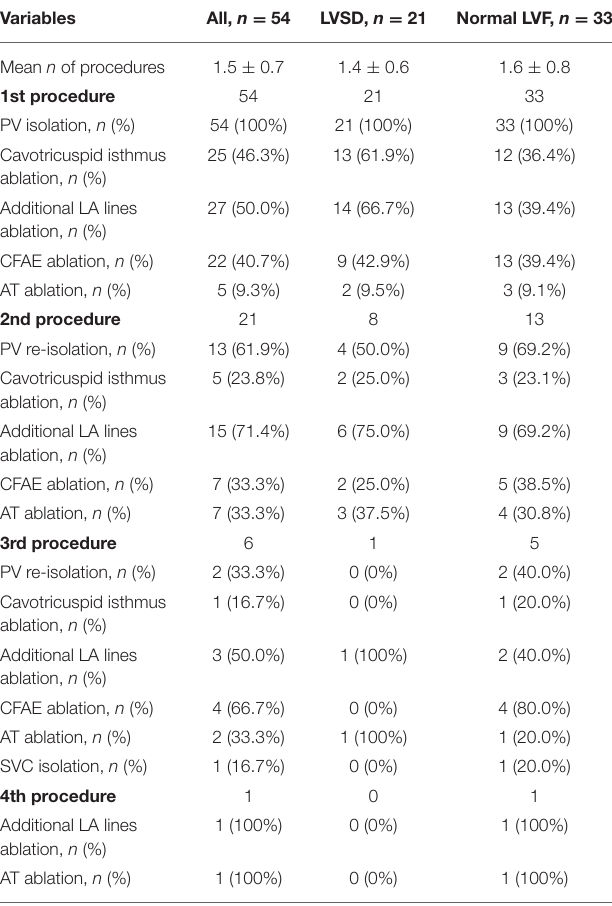
TABLE 2 | Details of the ablation procedures.